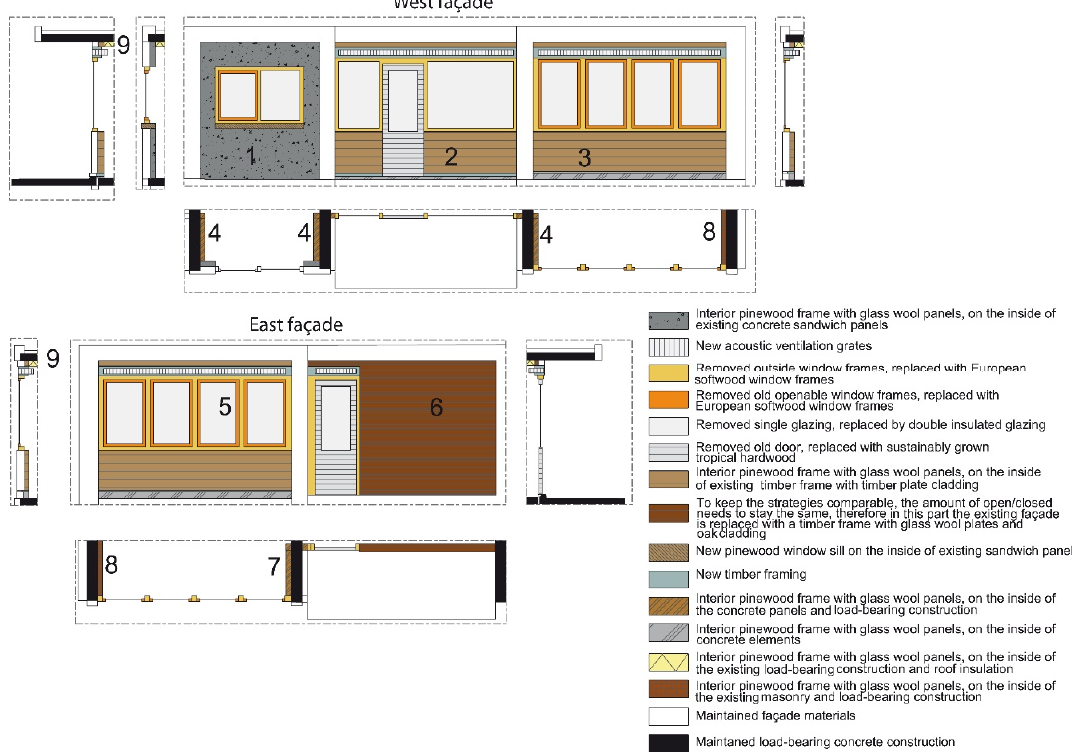
Figure 10. Interior upgrade design; insulation with a thermal resistance R = 3.5 W/m 2 K is added on the inside walls with a finish